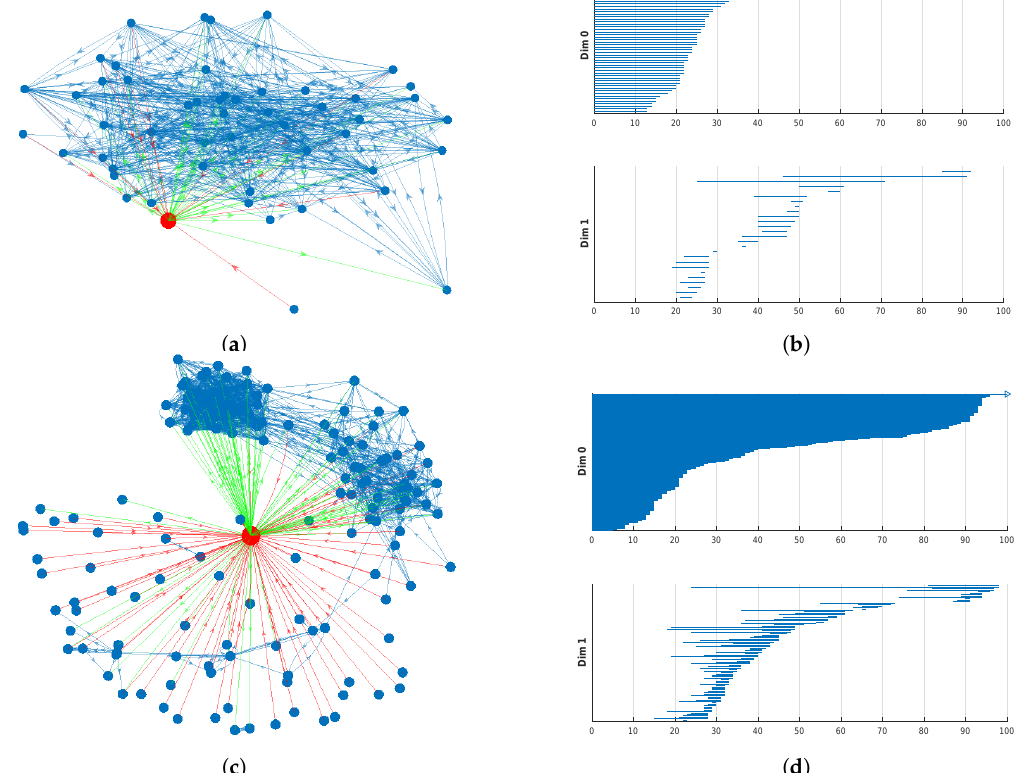
Figure 5. Ego network of a bot user ( a ), a human user ( c ), and their barcodes for dimension 0 and dimension 1, ( b ) and ( d ), respectively. In each ego network, the ego is colored red and its neighbors are colored blue. Also, the edges out-going from the ego are colored green, in-going to the ego are red and other edges between the neighbors are colored